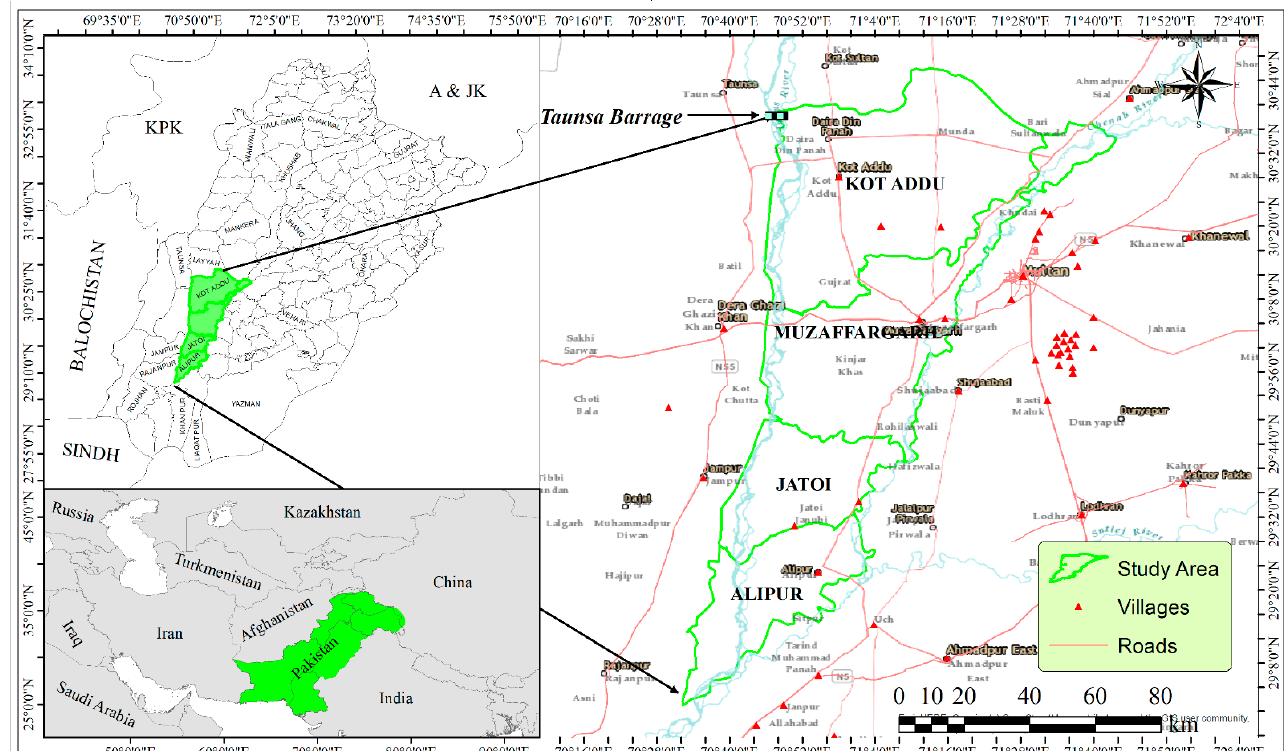
Figure 1. The subdivisions of Muzaffargarh District in the Punjab province of Pakistan.